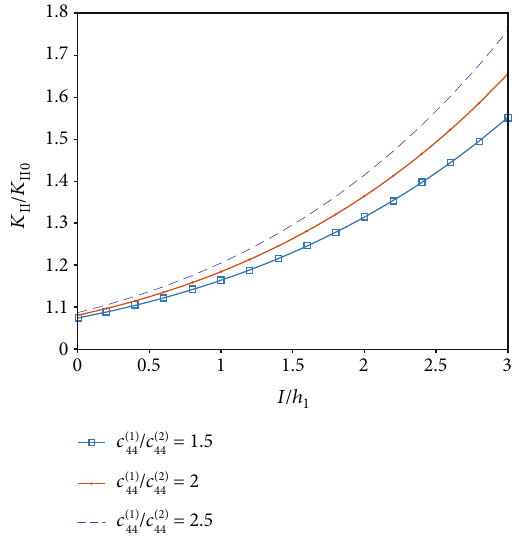
on mode I thermal stress intensity factor for 2 / h . 1 2